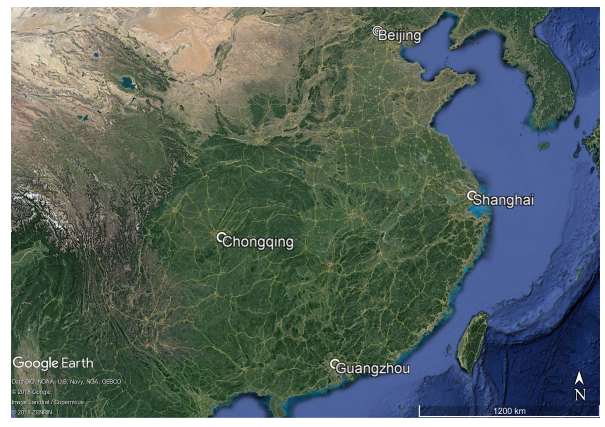
Figure 1. Locations of the four Chinese